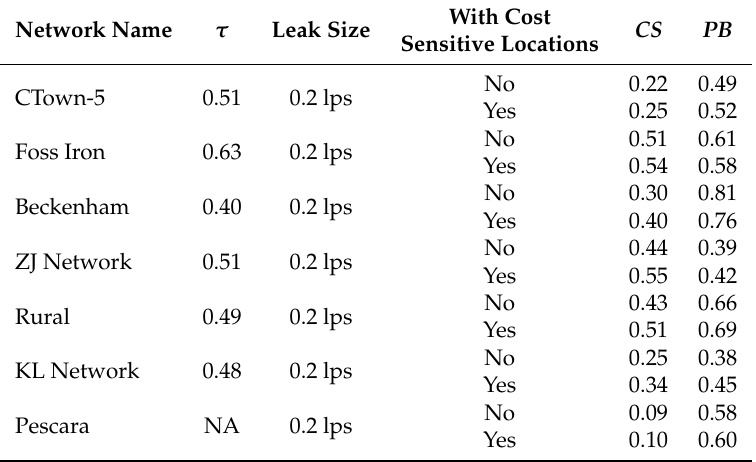
Table 4. Comparison of partition evaluation